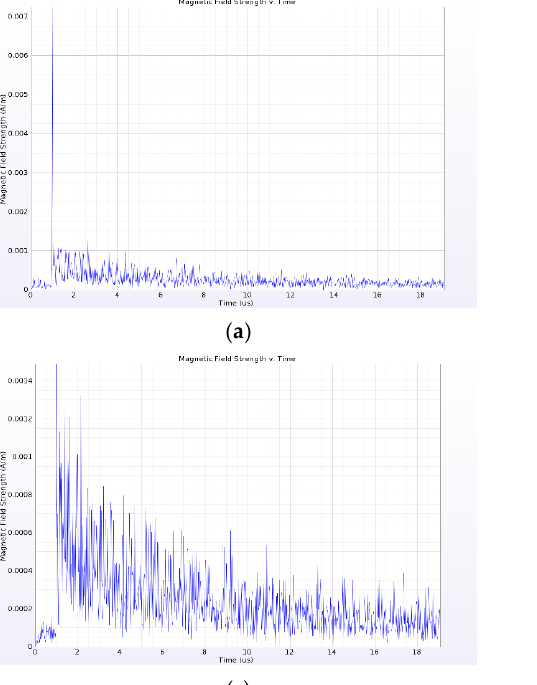
0.0023032 A/m, 0.0014875 A/m and 0.00085843 A/m , respectively. By comparing the PD electromagnetic wave signal graph observed at these four points, we can know that when the PD electromagnetic wave signal propagates through the air – insulator and insulator – air interfaces, the amplitudes of both the electric field strength and the magnetic field strength have a large attenuation, which indicates that the electromagnetic wave generates a reflection phenomenon when it propagates to the com- plex medium interface, resulting in the signal attenuation. In addition, after passing the insulator, the electromagnetic wave signal waveform also has obvious distortion, which has a certain impact on the signal recognition. Therefore, the insulator will not only atten- uate the amplitude of the PD electromagnetic wave signal, but will also cause obvious distortion to the signal. Therefore, the near - field probe should not be placed near the in- sulator. 4.3. Influence of Busbar on Near-Field Propagation Characteristics of PD Electromagnetic Wave Figure 11 shows the position relationship diagram of the PD excitation source and the point sensor around the busbar. Place the source on the surface of the busbar; the spe- cific location is (−250 mm, 650 m m, 0 mm), and the source length is 10 mm. Place two point sensors , 1 and 2 , in the space on the right of the source that are, respectively , (−300 m m, 650 m m, 0 mm) and (−3500 mm, 650 m m, 0 mm). Place point sensors 3 and 4 in the space behind the bus on the left side of the source. The specific positions are (150 mm, 650 m m, 0 mm) and (200 mm, 650 m m, 0 mm) , respectively. Through these four point sensors, we can observe the changes in the electric field strength and magnetic field strength of the PD electromagnetic wave signal before and after passing through the bus. See Figures 12 and 13 for details.